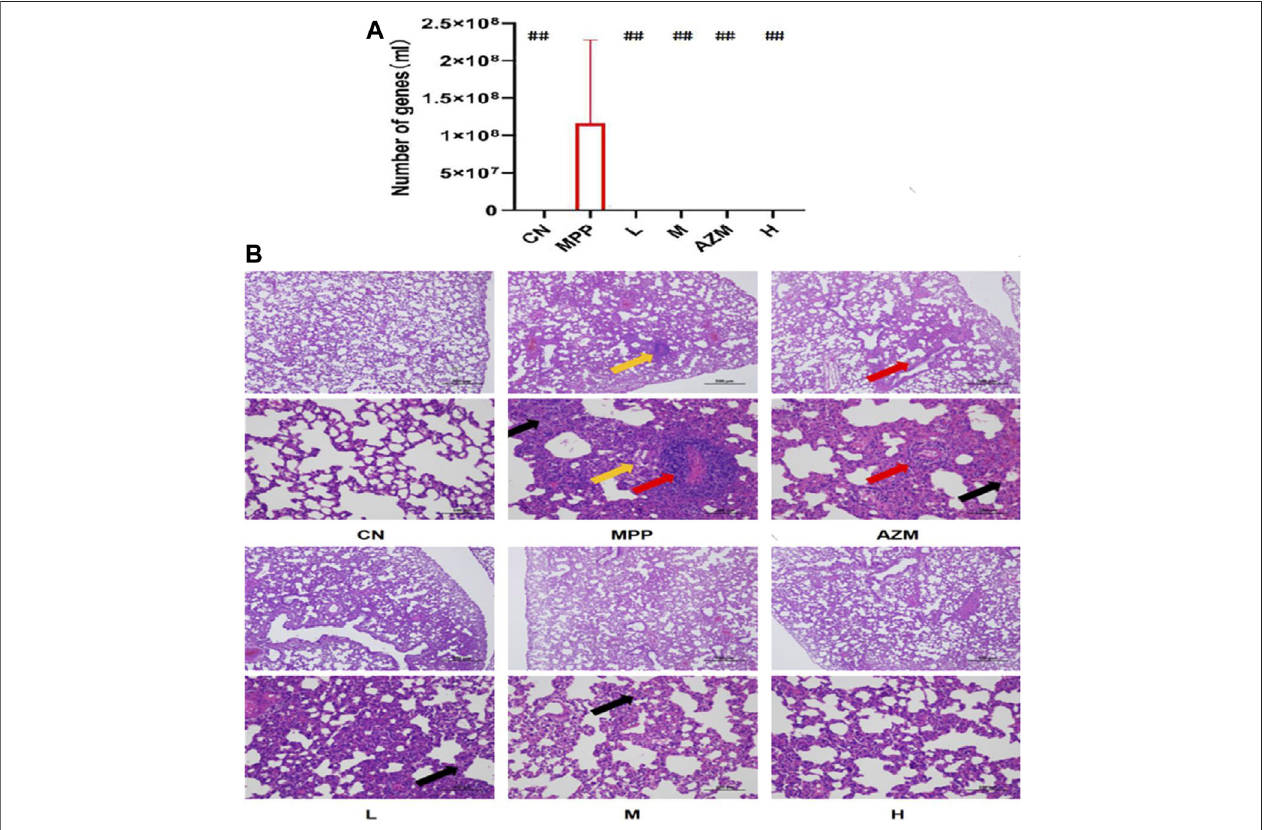
FIGURE 2 | HE staining of rat lung tissue and the amount of mycoplasma carrier in lung tissue. (A) RtPCR mycoplasma real-time fl uorescence detection, using analysisofvariancetocalculatethesigni fi cantdifference,comparedwiththeMPPgroup# p < 0.05,## p < 0.01. (B) Thealveolarwallofthecontrolgroupwascomposed of a single layer of epithelium with a simple structure; the interstitium, including the connective tissue and blood vessels in the lung, had no obvious abnormalities. In the Mycoplasma pneumoniae group, large areas of alveolar walls are severely thickened, alveolar sizes vary, alveolar walls are in fi ltrated with a large number of in fl ammatory cells (black arrows),and few ofthe foam cellsin thealveolar cavity(yellow arrows) and localperivascularin fl ammatorycells in fi ltrate intorings (red arrow). In theQBgroup,thealveolarwallwasslightlythickened,withasmallamountofin fl ammatorycellin fi ltrationinthealveolarwall(blackarrow).IntheAZMgroup,largeareasof alveolar walls were moderately thickened, alveolar sizes varied, and alveolar walls were in fi ltrated with moderate in fl ammatory cells (black arrows).